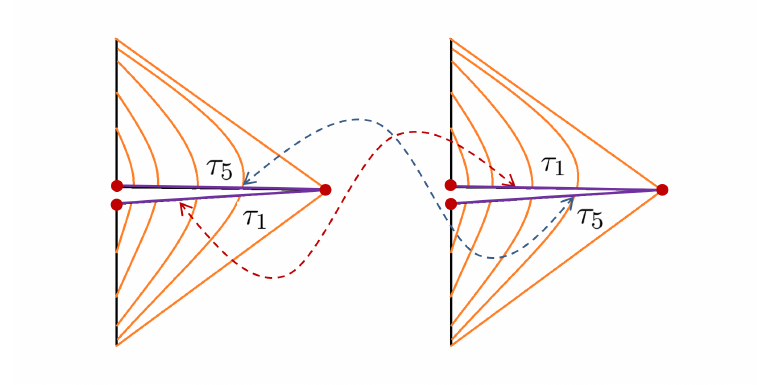
Figure 3: The replica trick applied to the modular slice when n = 2. Each slice is cut open at γ then glued cyclically. The dashed lines show the gluing boundary P